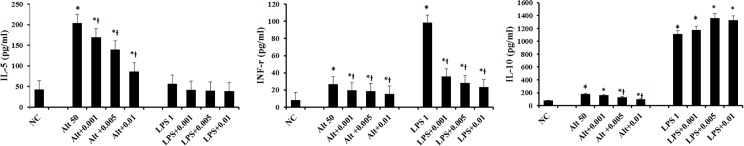
Effects of C. obtusa essential oil on dendritic cells (DCs) stimulated with Alternaria 50 ug/ml (Alt 50) and lipopolysaccharide 1 ug/ml (LPS 1) induced distinctive cytokines from autologous CD4+ T cells.Alternaria-induced interleukin-5 (IL-5), interferon gamma (INF-γ), and IL-10 production and LPS-induced INF-γ production were significantly inhibited with various concentrations (0.001–0.01%) of C. obtusa. NT: not treated with essential oil, * p < 0.05 vs. NC, Ɨ: p < 0.05 vs. Alt 50 or LPS 1.